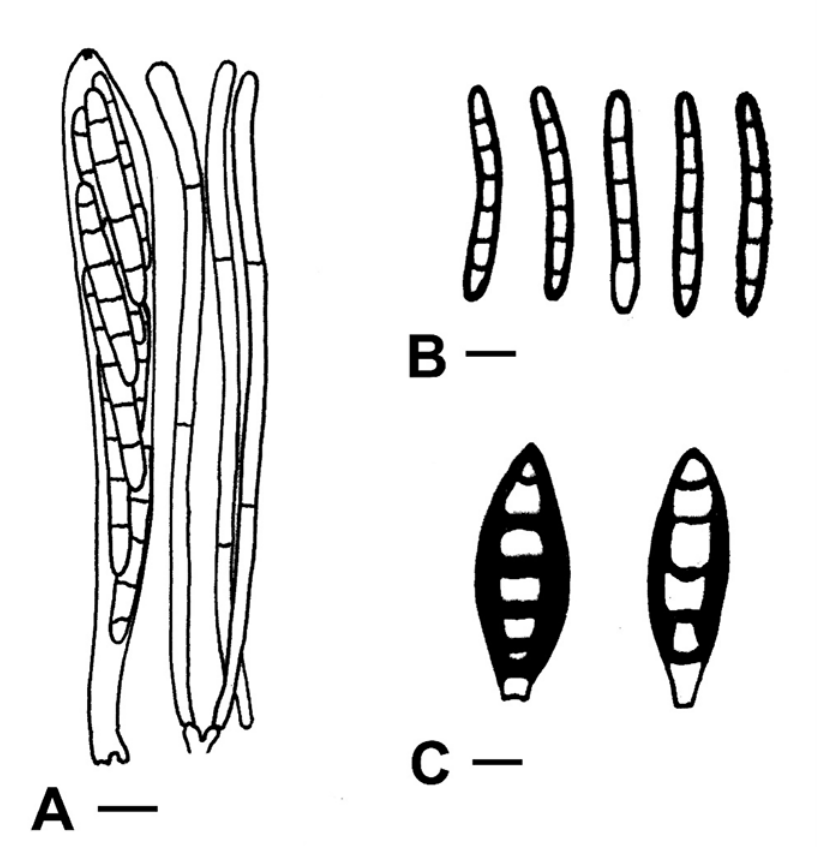
Figure 2 Microcharacters of Strossmayeria basitricha : ( A ) Ascus and paraphyses; ( B ) ascospores; ( C ) conidia. Scale bars: 10 μm. Drawing by B.